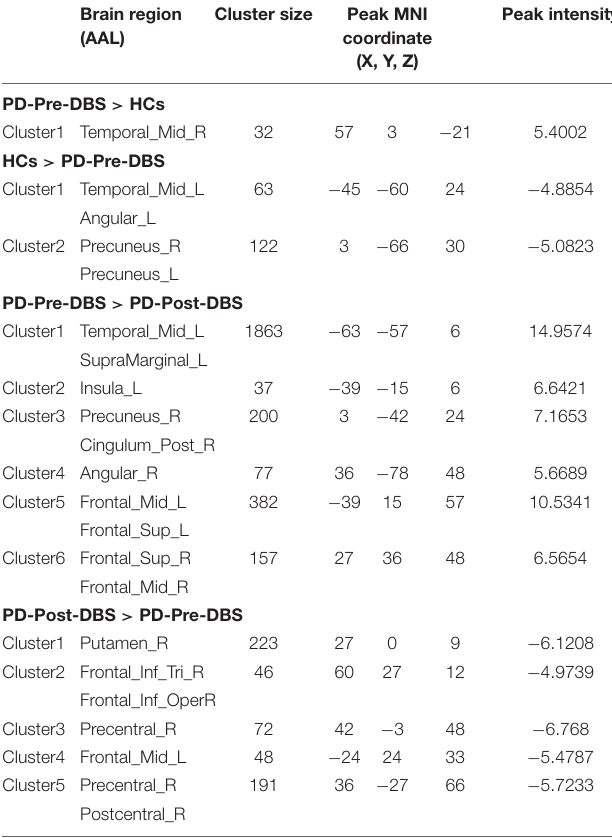
TABLE 2 | Alterations of ALFF between the PD-Pre-DBS group and HCs, as well as between the PD-Pre-DBS group and the PD-Post-DBS group (voxel p < 0.001, FWE correction with cluster p < 0.05).